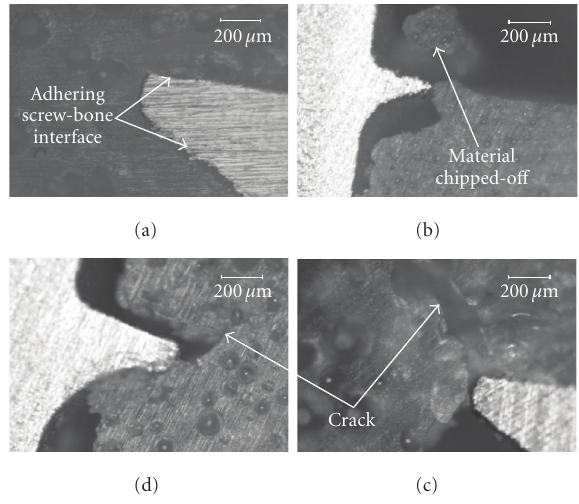
Figure 6: Images of polished specimens showing the thread-block interface for the following loads: (a) 566.4N and magnification of 200X (specimen S2), (b) 684.6N and magnification of 50X (specimen S3), (c) 783.9N and magnification of 200X (specimen S4), and (d) 891.3N and magnification of 100X (specimen